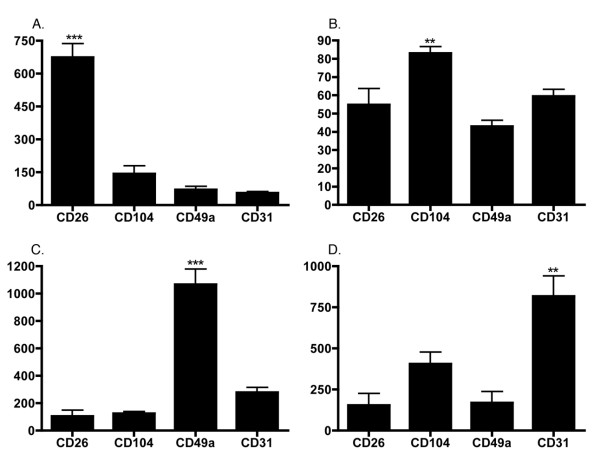
Effectiveness of cell sorting. Differential expression of transcripts that code for surface antigens targeted by MACS sorting. (A) luminal (CD26), (B) basal (CD104), (C) stromal (CD49a), and (D) endothelial (CD31). ANOVA results indicate significantly different expression at P < 0.001 (***) and P < 0.01 (**). Cell sorting enriched for the transcripts belonging to the gene that codes for the surface antigen that was the target of cell sorting.